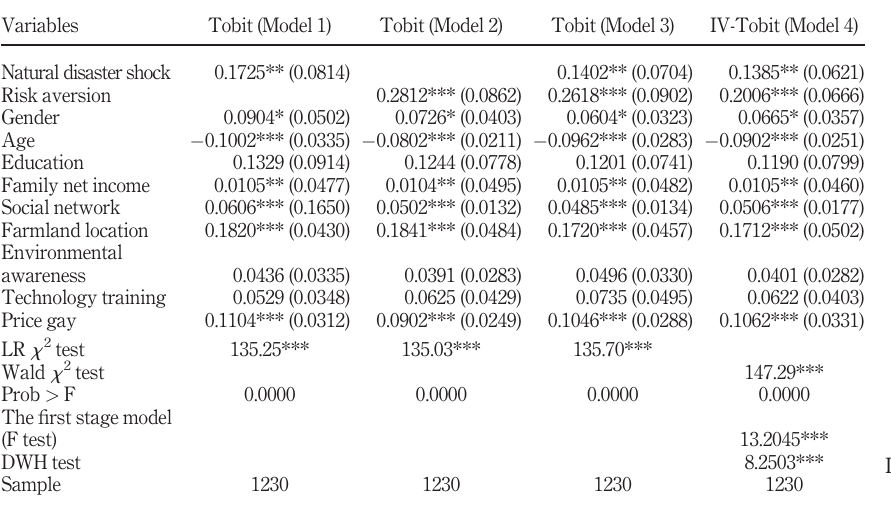
Table 4. In fl uencing effects